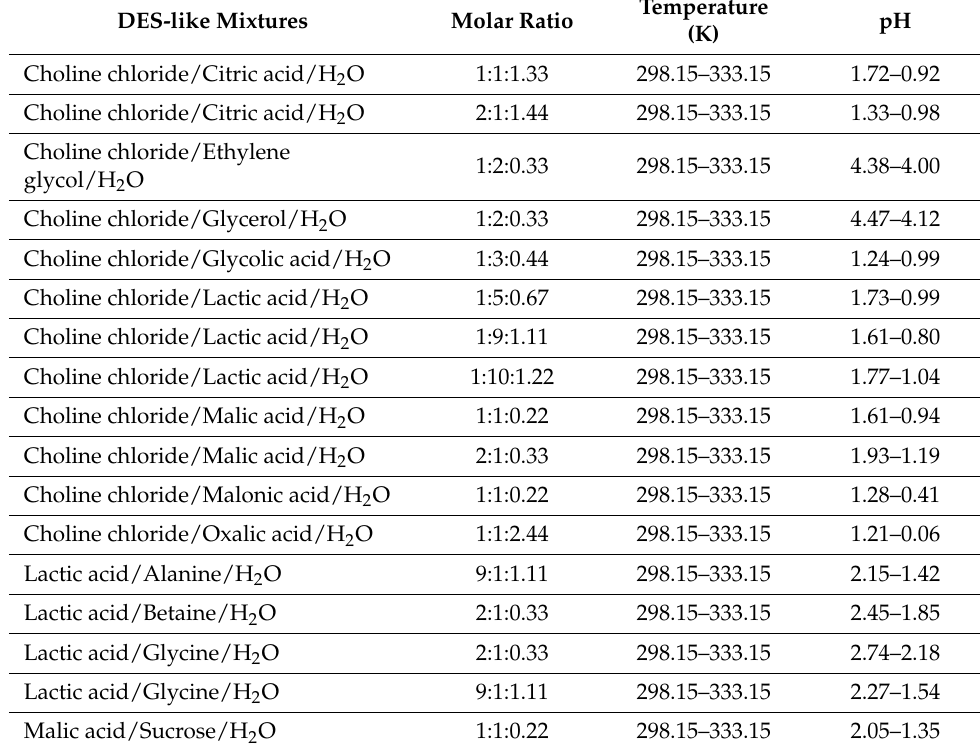
Table 11. Molar ratios, water contents, and pH values of DES-like mixtures used in (adapted according to Skulcova et al.)